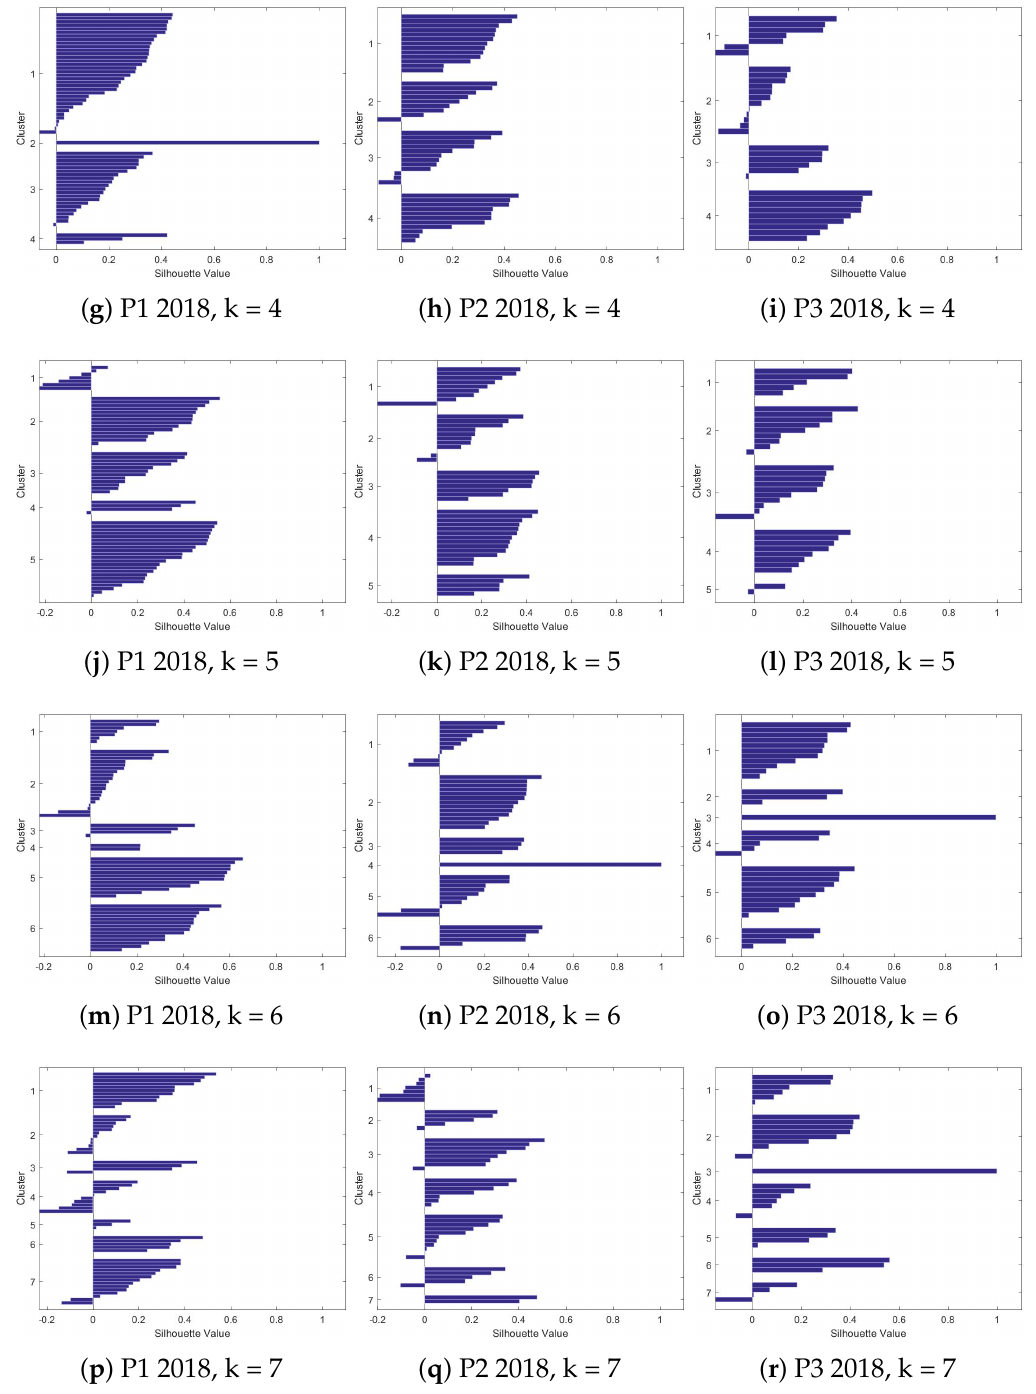
Figure 6. Silhouettes charts for three different times in 2018.